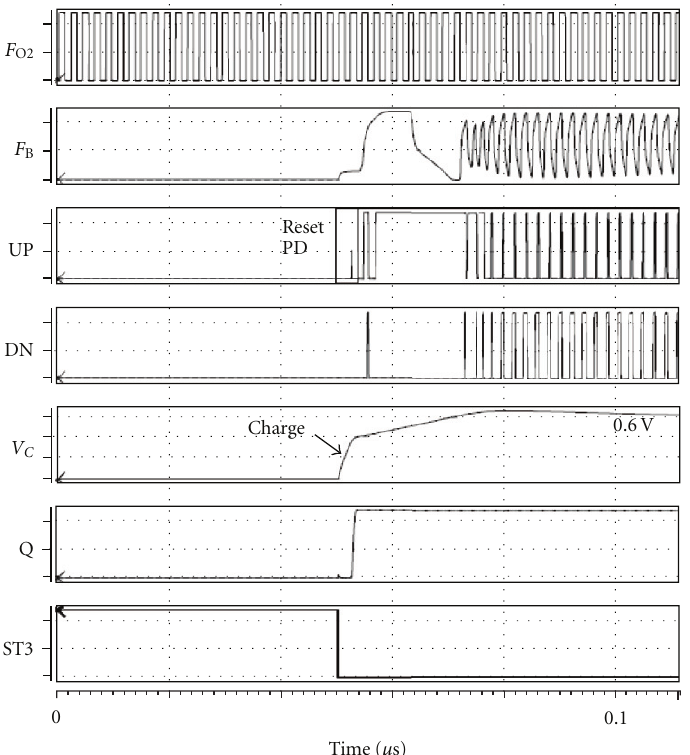
Figure 29: Postlayout simulation results from DLL3 locking operation. The simulation condition is tt/1.2V/25 ◦